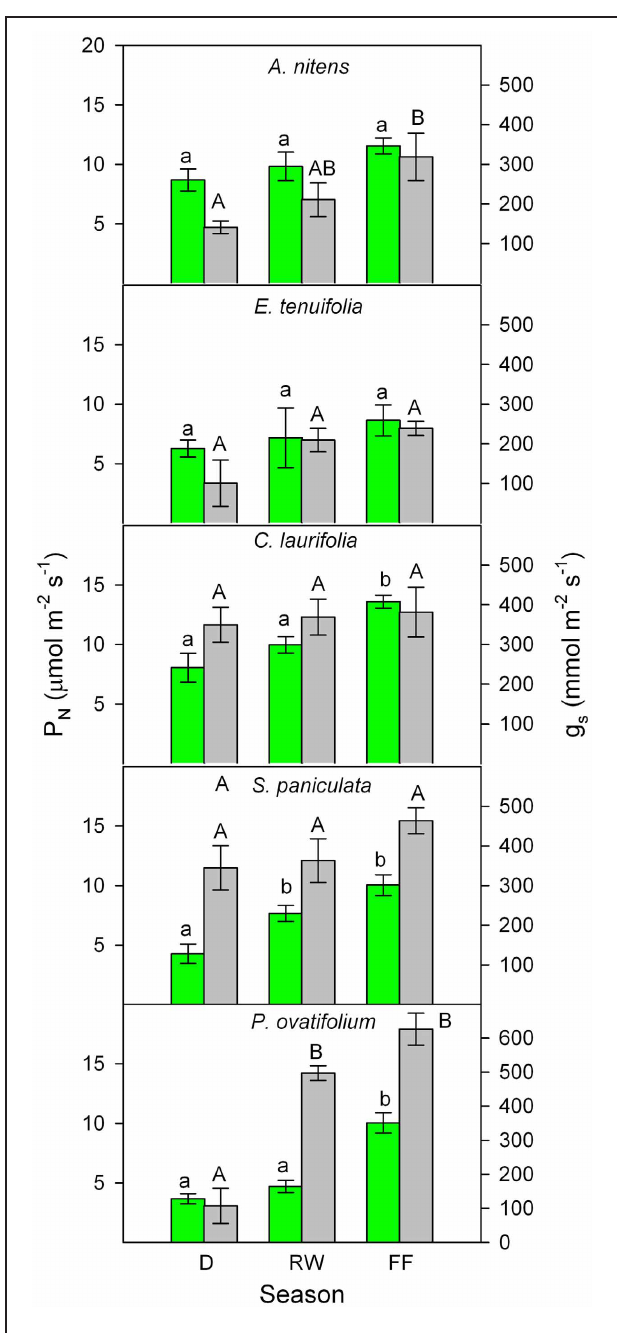
FIGURE 3 | Seasonal changes in photosynthetic rate (green) and stomatal conductance (gray) of the species indicated. Values are mean ± SE of measurements were made during 1995, 1996, 1998, 1999, 2000, 2003, 2004, and 2005. Different letters indicate significant differences at p < 0 . 05. Modified from Fernández et al. (1999), Rengifo et al. (2005), and Herrera et al. (2008a).